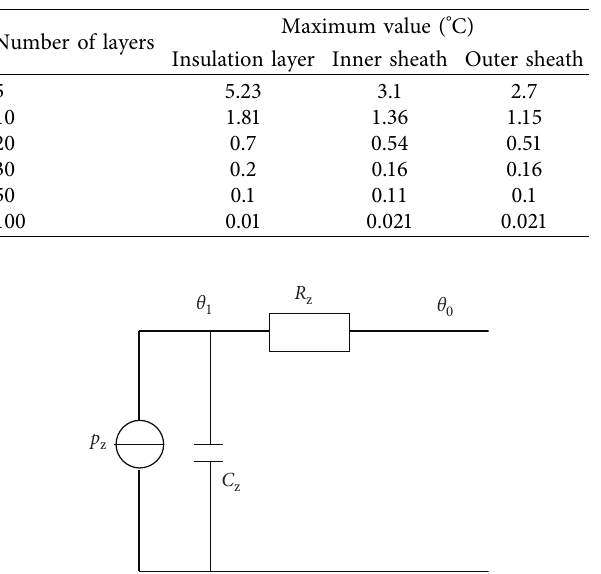
Figure 15: Equivalent first-order thermal circuit model of